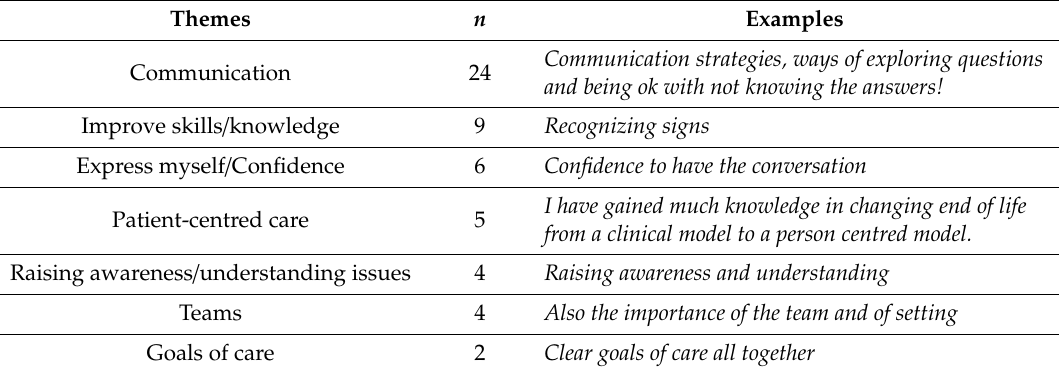
Table 2. Exemplars of learnings important to care categorised by